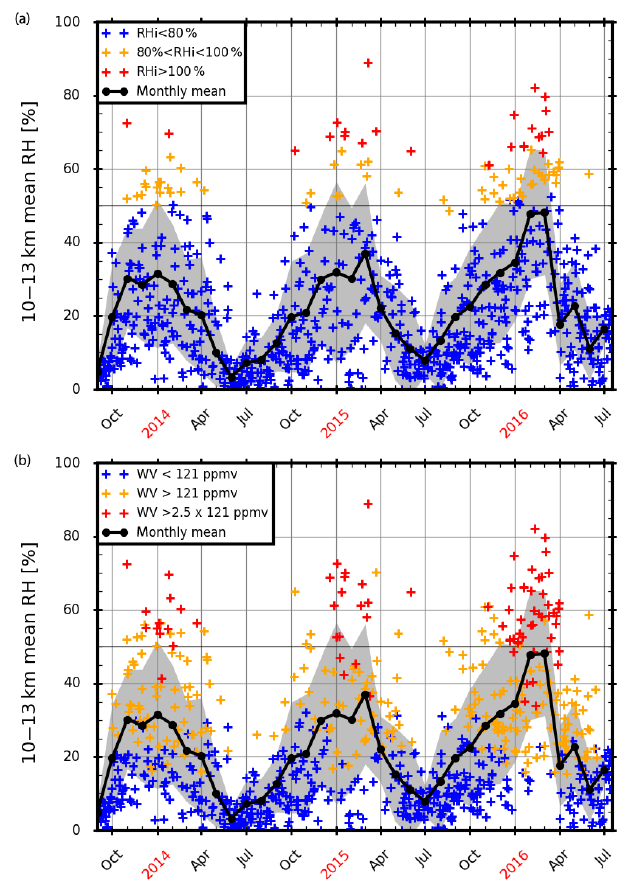
Figure 4. (a) Daily evolution of mean upper tropospheric (10 to 13km) RH for the period September 2013 to July 2016. The RH (with respect to water) values are color-coded according to the val- ues of RHi. In blue are RH values for RHi<80%, in orange are RH values for 80%<RHi<100%, and in red are RH values for RHi>100%. (b) Daily evolution of mean upper tropospheric (10 to 13km) RH for the period September 2013 to July 2016. The RH (with respect to water) values are color-coded according to the val- ues of water vapor mixing ratios (WV). The mean 10–13km WV is 121ppmv. In blue are RH values for WV<121ppmv, in orange are RH values for 121ppmv<WV<2 . 5 × 121ppmv and in red are RH values for WV>2 . 5 × 121ppmv. On the two panels, the thick black line corresponds to the monthly-mean RH in the upper